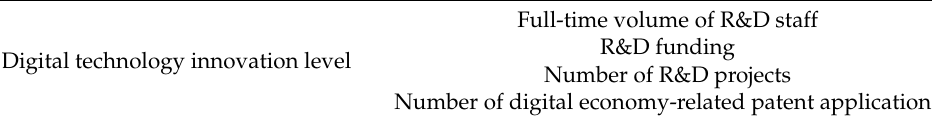
Table 2. Evaluation system of China’s digital innovation